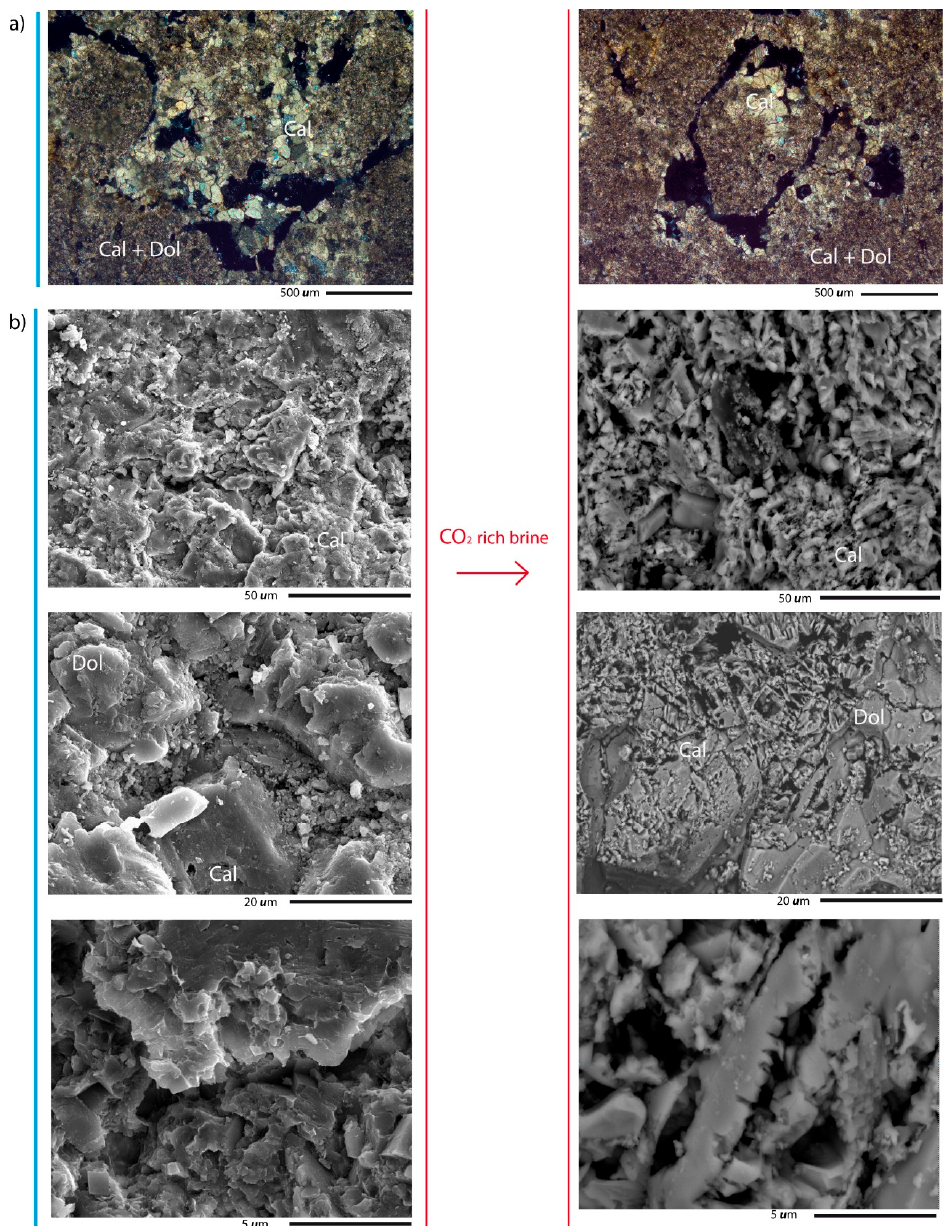
Figure 4. Changes in the pore network configuration of the limestone after SC CO 2 rich brine exposure. ( a ) Before (left) and after (right) images obtained by OpM showing an increased connectivity between pores after the experiment; ( b ) Before (left) and after (right) images obtained by SEM showing an increased surface roughness of calcite crystals due to dissolution at three different scales.